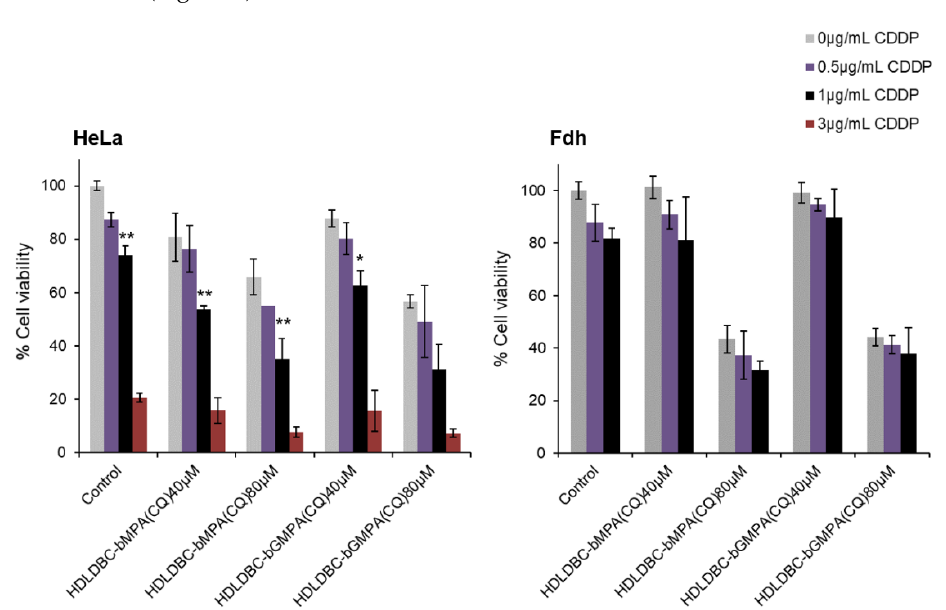
Figure 6. Effect of pre-treatment with CQ encapsulated in HDLDBC-bMPA or HDLDBC-bGMPA and treatment with free